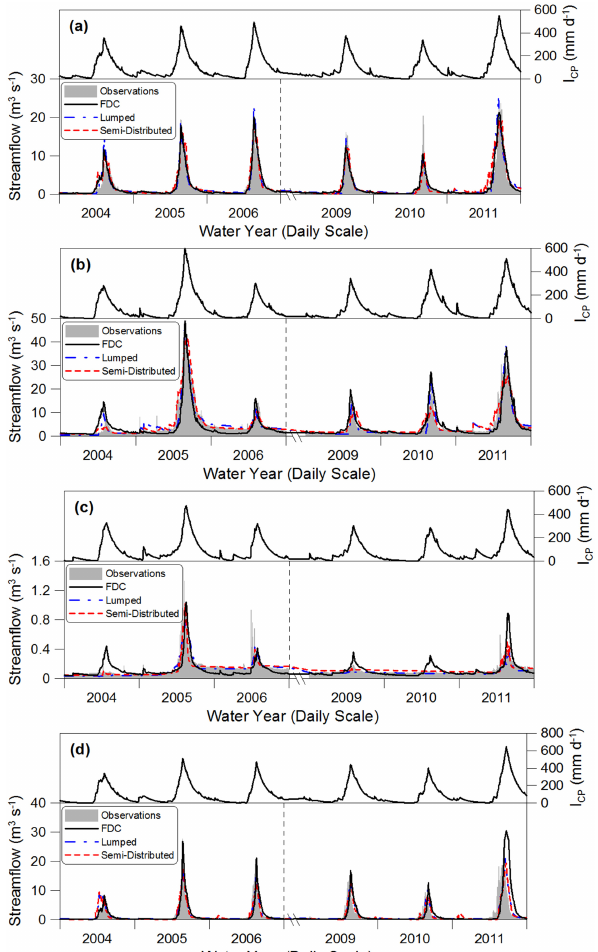
Fig. 5. Simulated streamflows with the FDC and the tank model: (a) Ferron Creek, (b) Sevier River at Hatch, (c) Vernon Creek, and (d) Fish